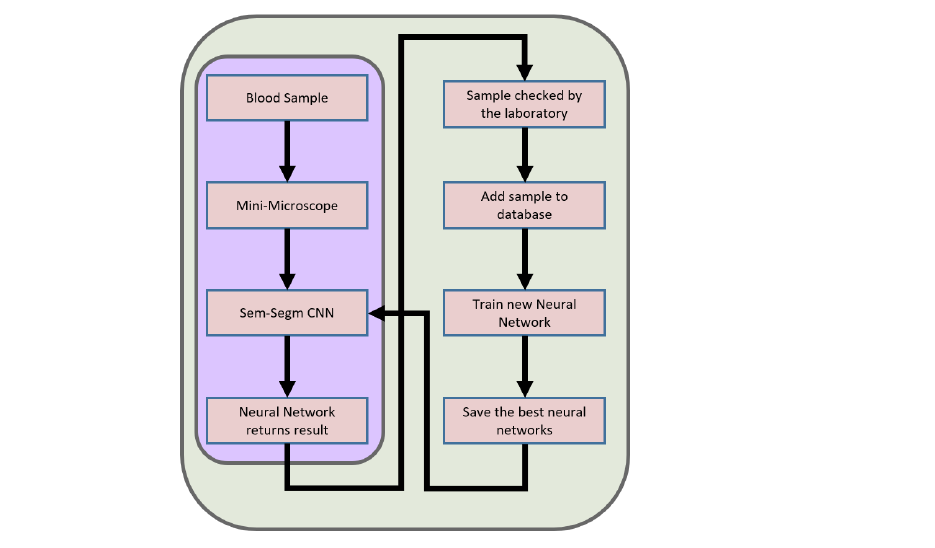
Figure 6. In the diagram above, we can see the data transfer in our device. When Internet access is difficult, the device switches to independent operation, which is marked in the diagram with a violet outline. If the connection is possible, the device forwards the data to enable augmentation of data used to learn the next generation of the neural network.